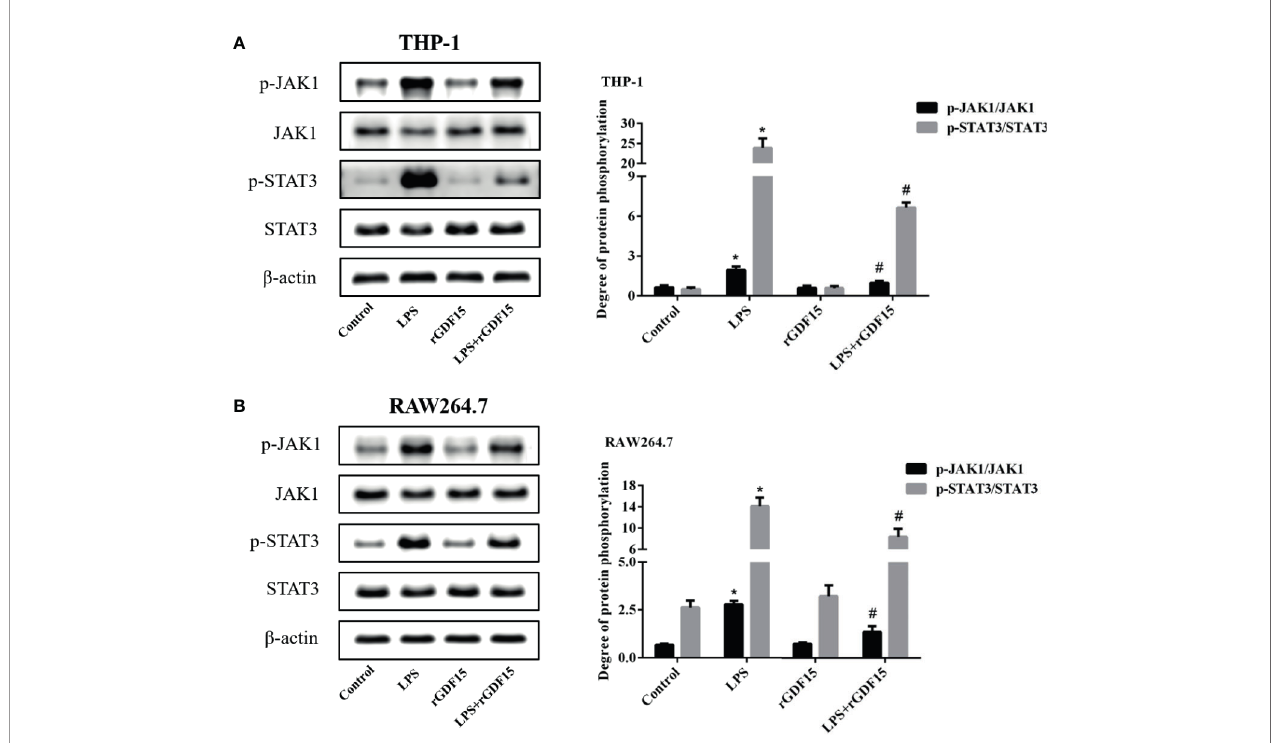
FIGURE 13 | Phosphorylation of JAK1/STAT3 pathway in THP-1 (A) and RAW264.7 (B) cells pretreated with rGDF15 in in fl ammatory state was detected by Western blot; the protein band diagram and quantitative analysis results were shown here. * P < 0.05, compare with the control group; # P < 0.05, compare with the LPS group.